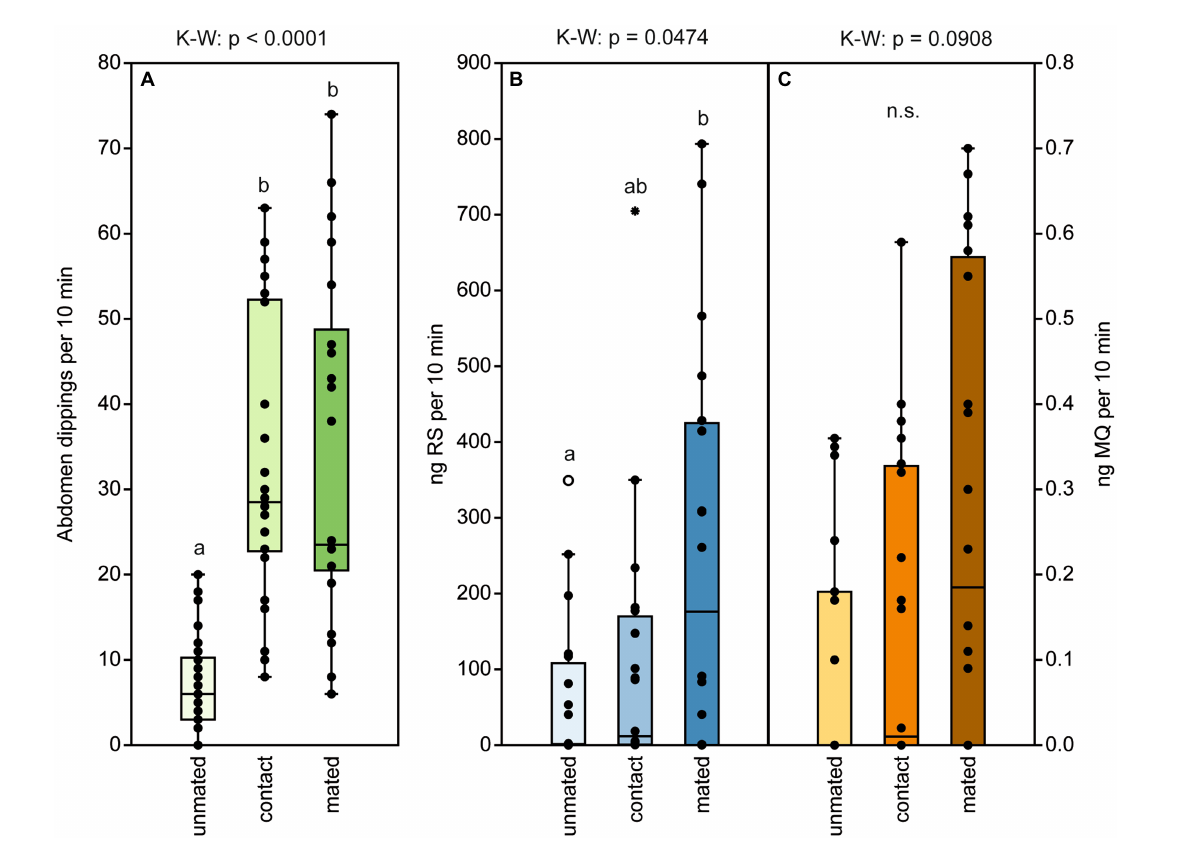
FIGURE 6 Male abdomen dipping serves to deposit pheromone and increases in frequency after mating and contact with a female. (A) Frequency of abdomen dipping shown by males within a 10-min observation time. Males were either unmated (naïve), had contact with a female, or were allowed to mate with a female. ( Β ) Amounts of (4 R ,5 S )-5-hydroxy-4-decanolide (RS) and (C) 4-methylquinazoline (MQ) deposited by males of the three treatments within 10 min in a thermal desorption tube. Box and whisker plots show median (horizontal line), 25%–75% quartiles (box), maximum/minimum range (whiskers) and outliers ( ° >1.5 × above box height; *>3 × above box height). Different lowercase letters indicate significant differences between the treatments at p < 0.05 [n.s. = non significant, n = 10, data analysis by a Kruskal–Wallis H -test (K–W) followed by multiple Bonferroni-corrected Mann–Whitney U